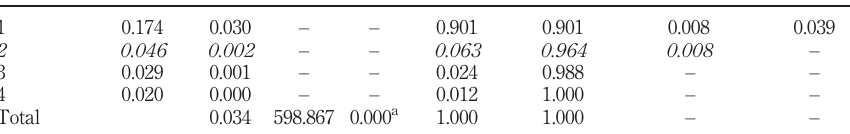
DimensionSingular valueInertiaChi-square